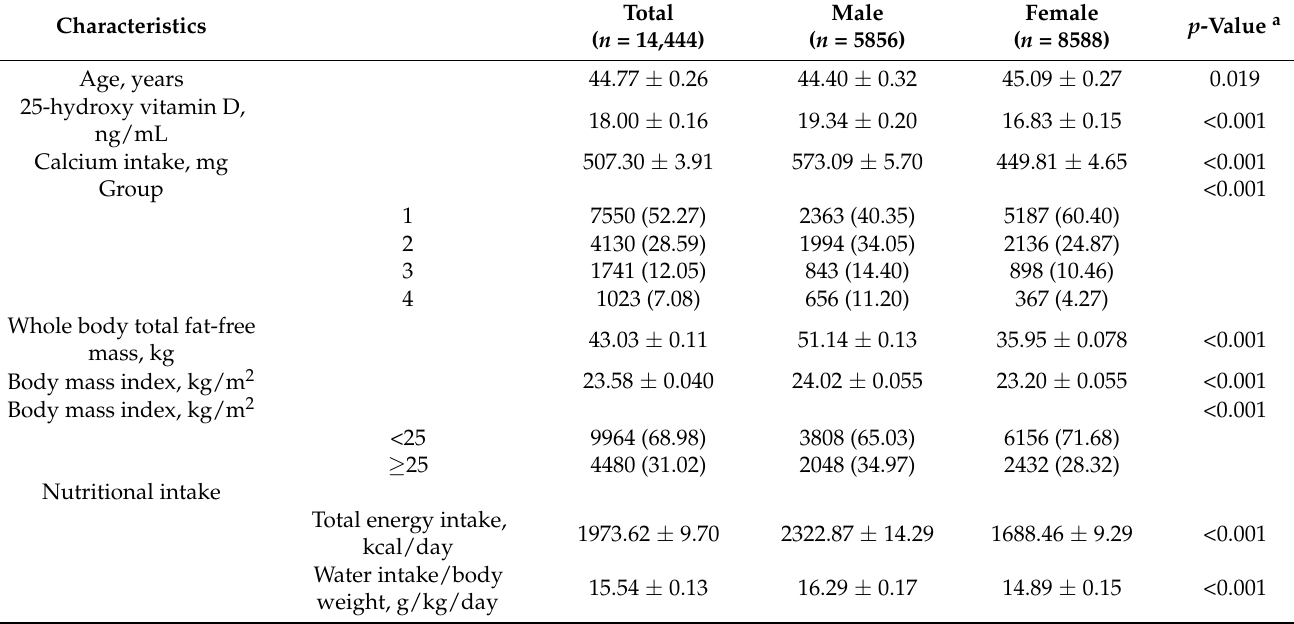
Table 1. Basic characteristics of the participants by